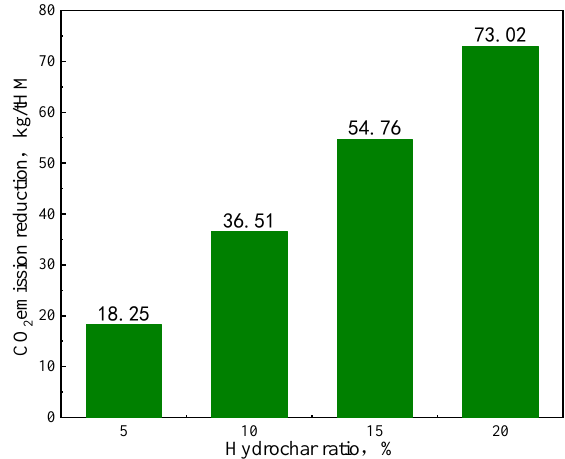
Figure 10. Effect of blast furnace injection of hydrochar on CO 2 emission